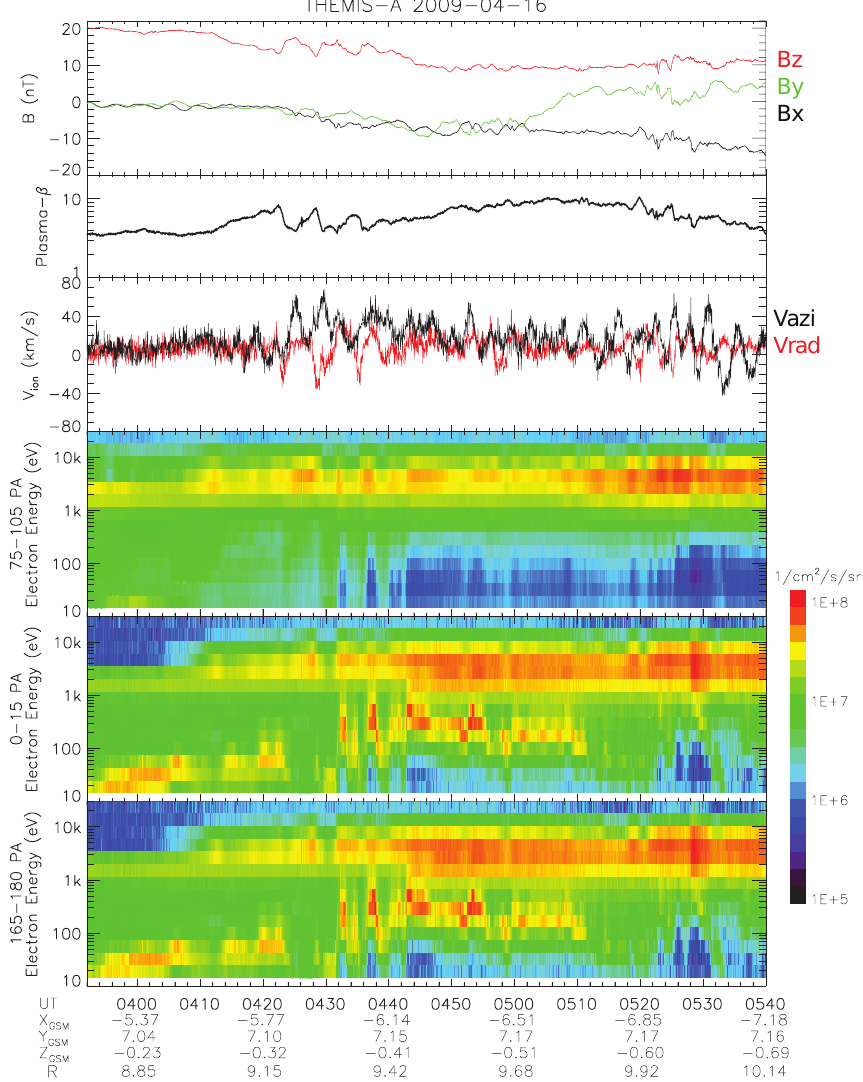
Fig. 4. TH-A observations on 16 April 2009. From top to bottom panels are the magnetic fields in GSM components, the plasma β , the azimuthal (positive duskward) and radial (positive earthward) ion flows, and the electron energy flux spectrograms in perpendicular ( α ∼ 75– 105 ◦ ), parallel ( α ∼ 0–15 ◦ ), and antiparallel ( α ∼ 165–180 ◦ )